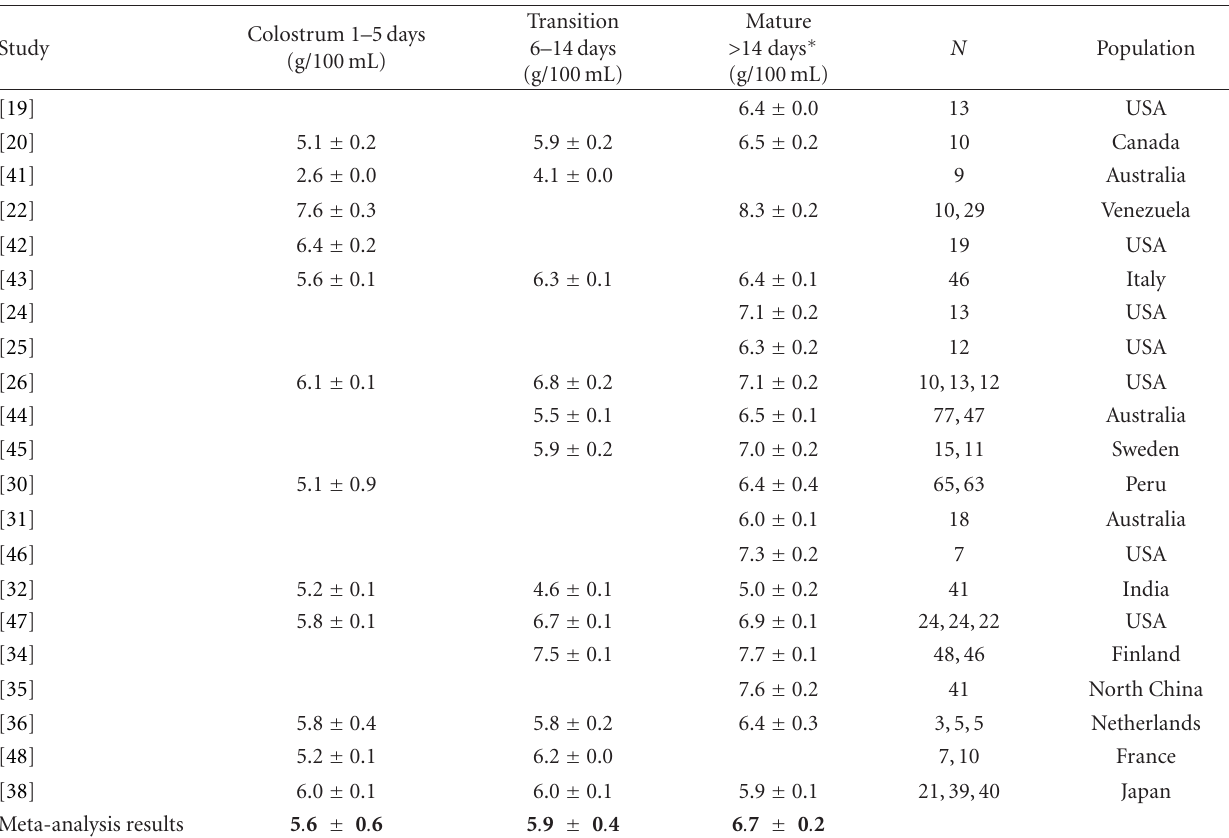
Table 3: Carbohydrate concentration in breast milk (g/100